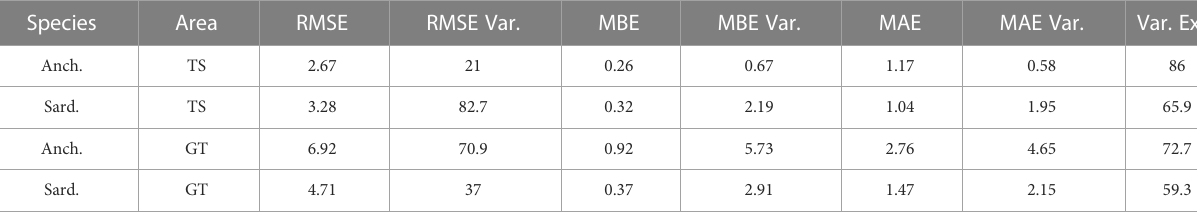
TABLE 2 Accuracy indices of RMSE, MBE, and MAE through Leave-One-Out cross-validation. Species Area RMSE RMSE Var. MBE MBE Var. MAE MAE Var.